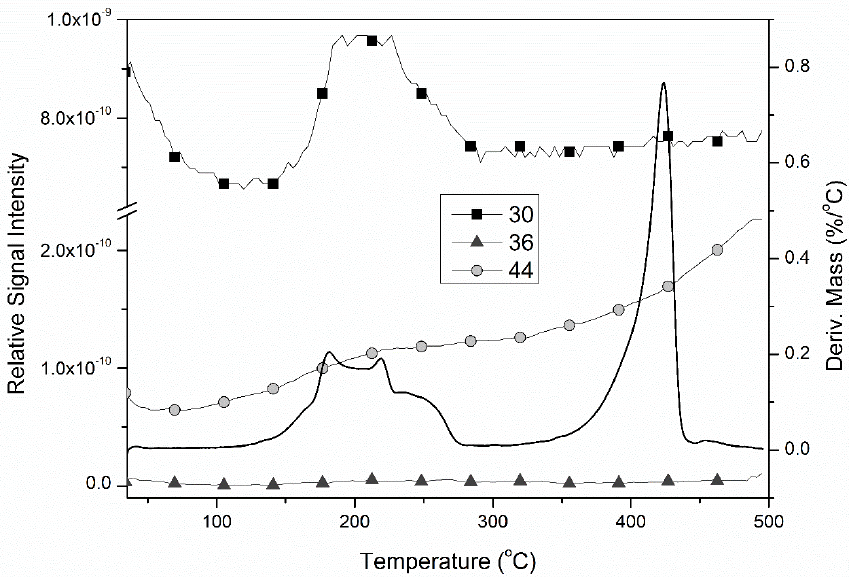
Figure 8. TG−MS of compound 1 in an inert atmosphere, the formation of m / z = 28 (N 2+ ) and m / z = 18 (H 2 O + ).